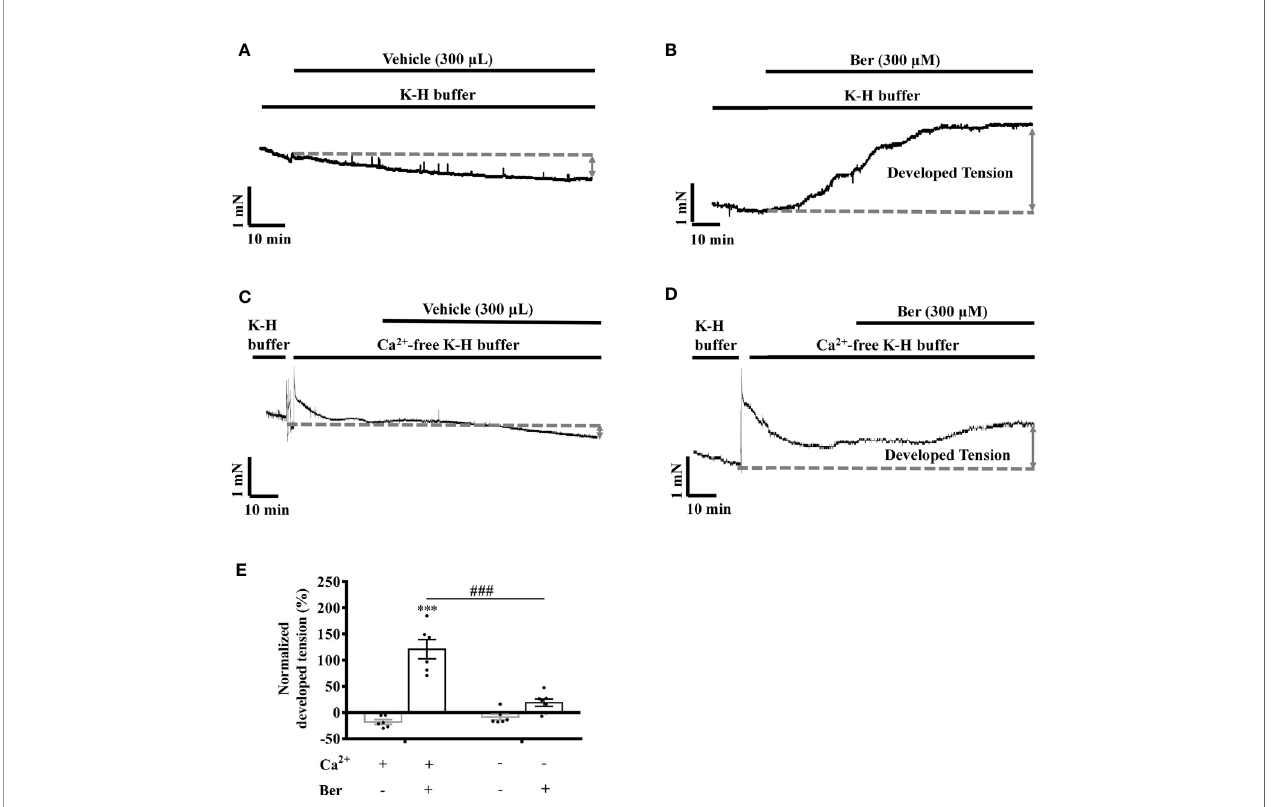
FIGURE 6 | The removal of extracellular Ca 2+ hindered the berberine-induced tension increase in left ventricular muscle (LVM) strips. (A – D) Original isometric tension recordings of the LVM strips treated with vehicle (A) , 300 m M Ber (B) ; vehicle (C) and 300 m M Ber (D) under the Ca 2+ -free condition, respectively. (E) Summary data showing that the removal of extracellular Ca 2+ signi fi cantly reduced the ability of berberine to increase the tension of LVM strips. The numbers of repeats are as follows: vehicle control of 300 µM Ber, n = 6, N = 6; 300 µM Ber, n = 6, N = 6; vehicle control of 300 µM Ber in the Ca 2+ -free Krebs-Hensseleit (K-H) buffer, n = 6, N = 6; 300 µM Ber in the Ca 2+ -free K-H buffer, n = 7, N = 7; n and N are the numbers of LVM strips and rats, respectively. Ber stands for berberine. ***p < 0.001 vs. vehicle control group; ### p < 0.001 vs. Ber-treated group in the normal K-H buffer; two-way ANOVA with Tukey's multiple comparisons